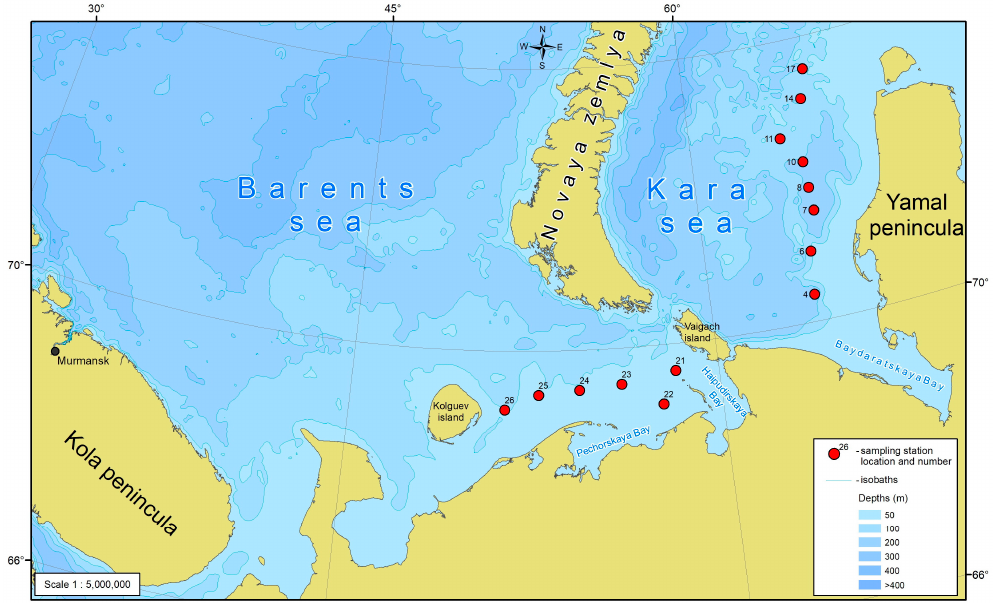
Figure 1. Study area and the location of sampling stations. For this and further schemes, gridded bathymetry data for the Arctic Ocean area (IBCAO) from GEBCO Digital Atlas (version 2.12) were used.